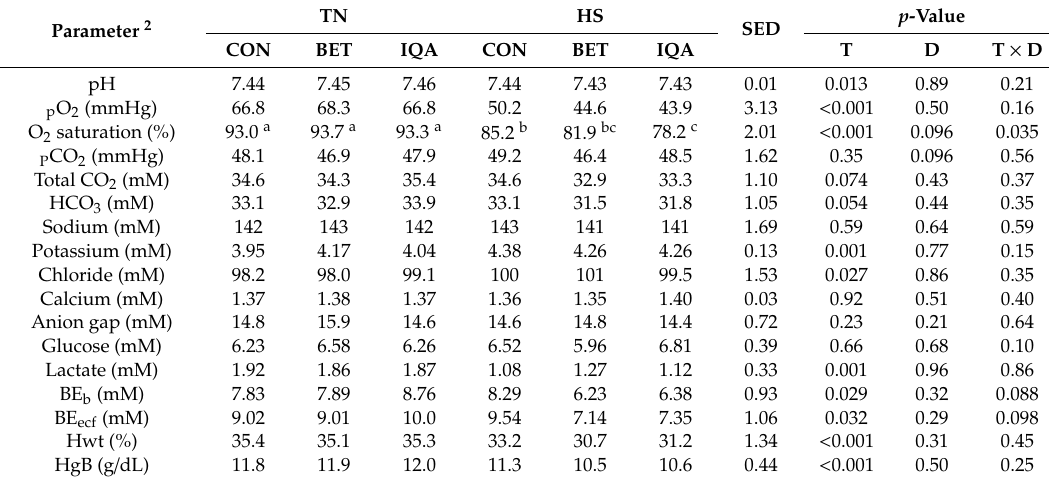
Table 2. E ff ect of thermoneutral (TN) and heat stress (HS) conditions and control (CON), betaine (BET) or isoquinoline alkaloids (IQA) diets on blood gases and electrolytes 1